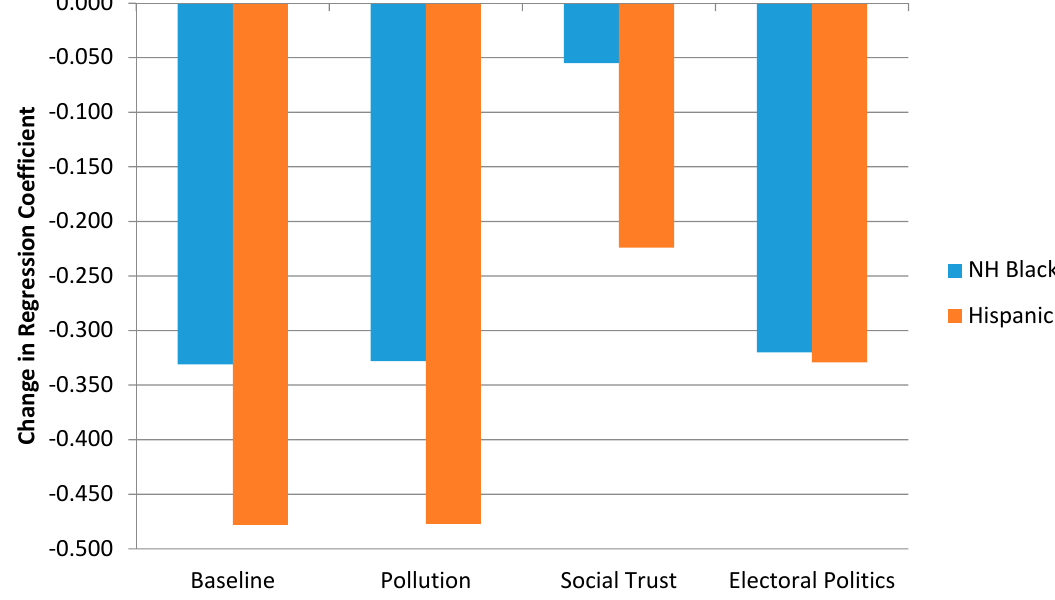
Figure 1. Changes in regression coefficient for an individuals’ race to predict self-rate health when accounting for differential pollution exposure and social capital.